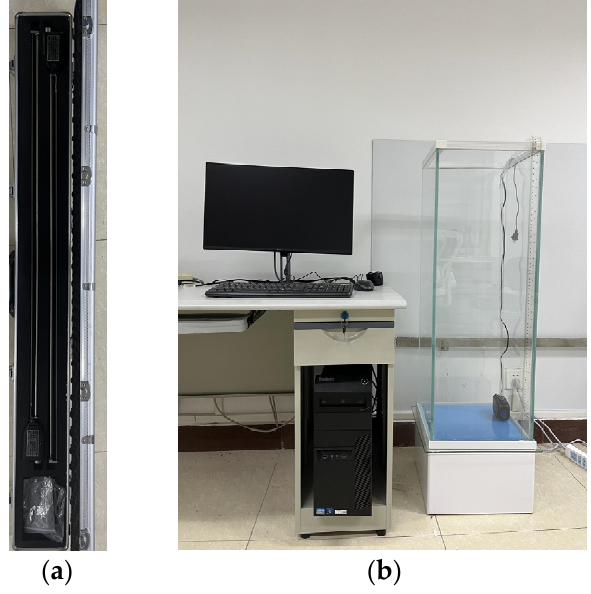
Figure 3. Wave probe( a ) and calibration facility( b ).